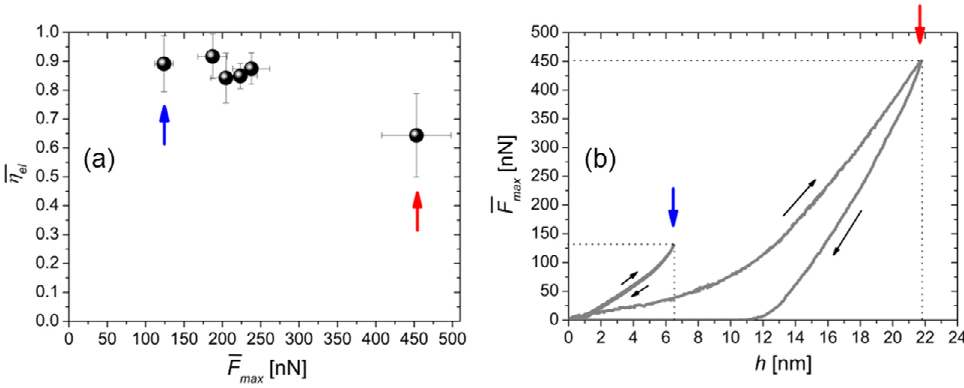
Figure 2. ( a ) Plot of η vs. F max . ( b ) Two representative F-h curves taken from the maps recorded respectively at F max = (120 ± 11) nN and (453 ± 49) nN and corresponding to η and (0.643 ± 0.146), namely the first and last points of the graph in ( a ). Blue and red arrows are a guide to the